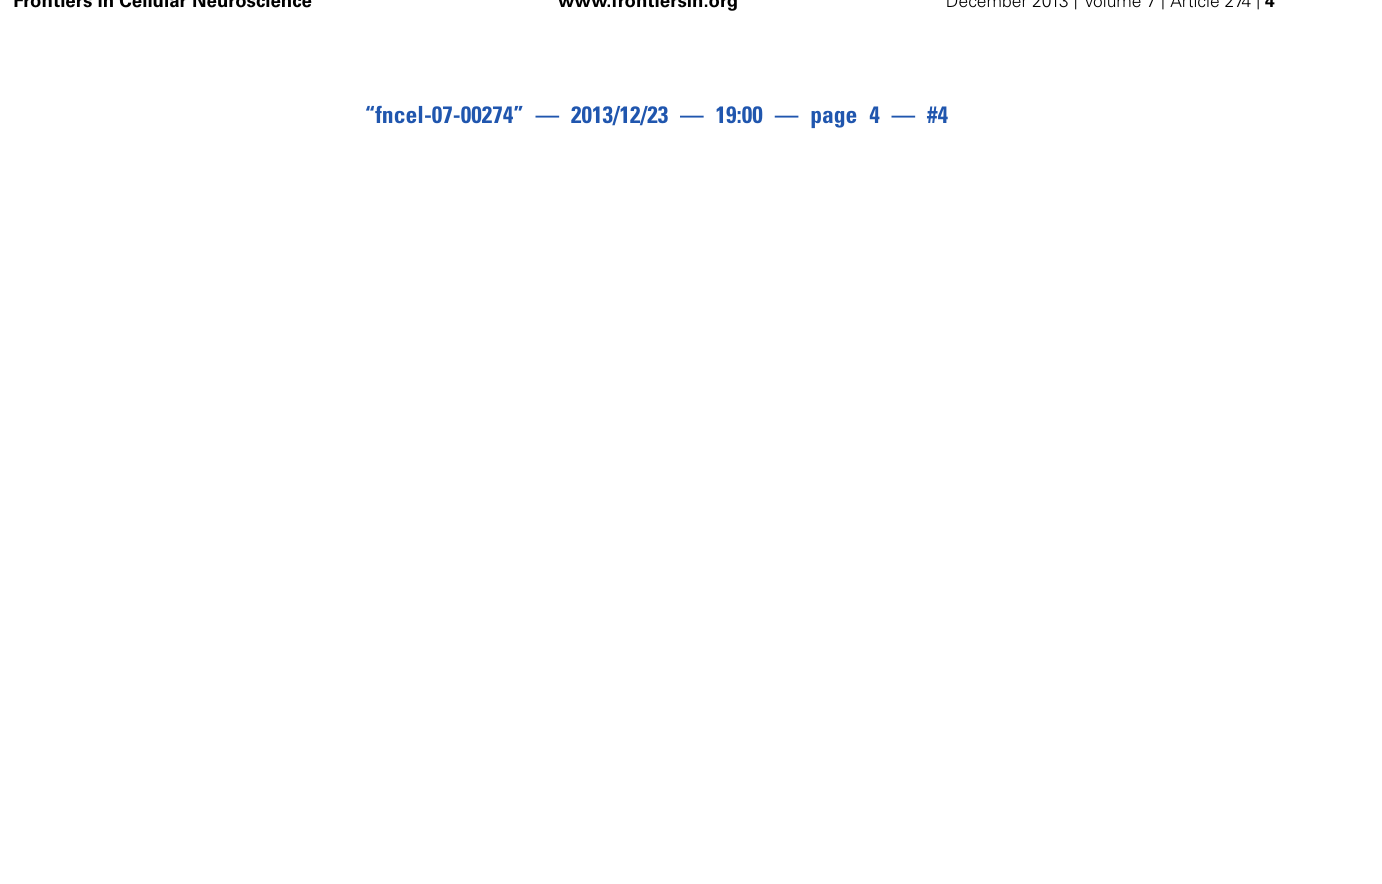
located around the motor neurons (indicated as dotted lines) and their processes closely embrace the neuronal cell body. The arrows indicate double-labeled cells. Note the unspecific binding of Ki67 antibody to motor neuron cell bodies. (B) Ratio of GFAP/Ki67 and Iba1/Ki67-positive cells per motor neuron in symptomatic and asymptomatic rats. The scheme at the left shows the methods used to count the cells in a perimeter of 100 μ m around motor neurons. The counting was performed in 10 histological sections per animal. Two different rats were used for each condition. Data are shown as mean ± SD; * P < 0.05. Scale bars: 100 μ m for low magnification panels; 20 μ m for high magnification